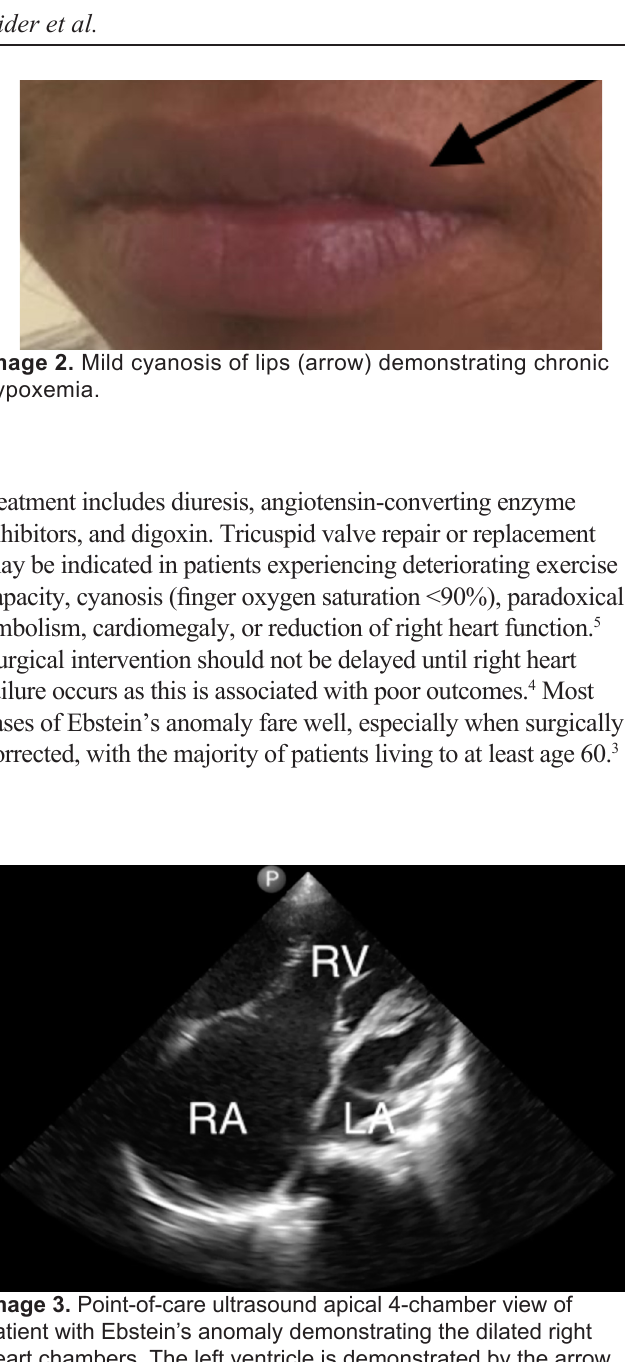
Video. An apical 4-chamber cardiac ultrasound obtained in a patient with Ebstein’s anomaly demonstrating the dilated right- sided chambers. The left ventricle is demonstrated by the arrow. RV, right ventricle; RA, right atrium; LA, left atrium arrow.